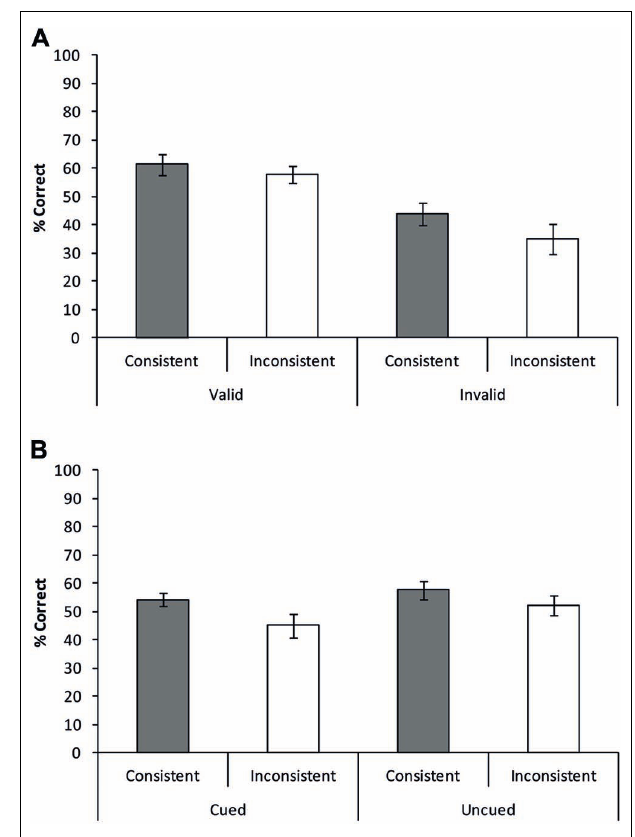
FIGURE 6 | Scene consistency effects as a function of attentional cueing to the target location in (A) Experiment 3a and (B) Experiment 3b. Similar to Experiments 1 and 2, participants were more accurate in recognizing objects presented on a consistent background, compared to an inconsistent background. Importantly, scene consistency effects were equally strong for trials in which the location of the target was cued as for trials in which the location of the target object was not (Experiment 3b) or invalidly (Experiment 3a) cued. Error bars reflect the standard error of the